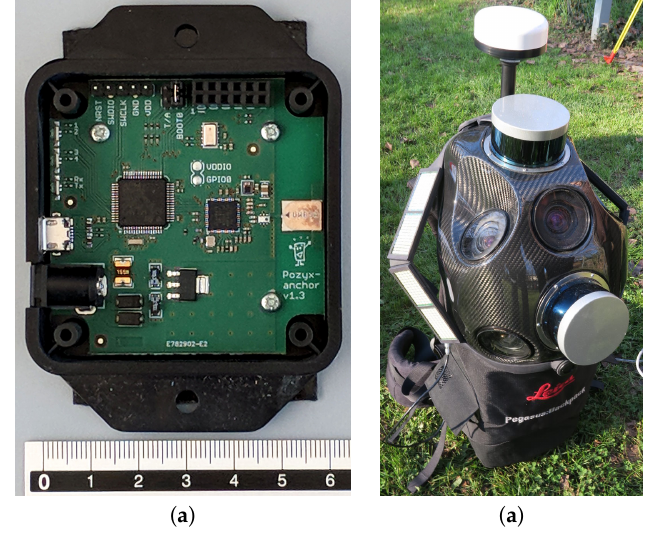
Figure 1. ( a ) UWB Pozyx device (beside a centimeter ruler). ( b ) Leica Pegasus